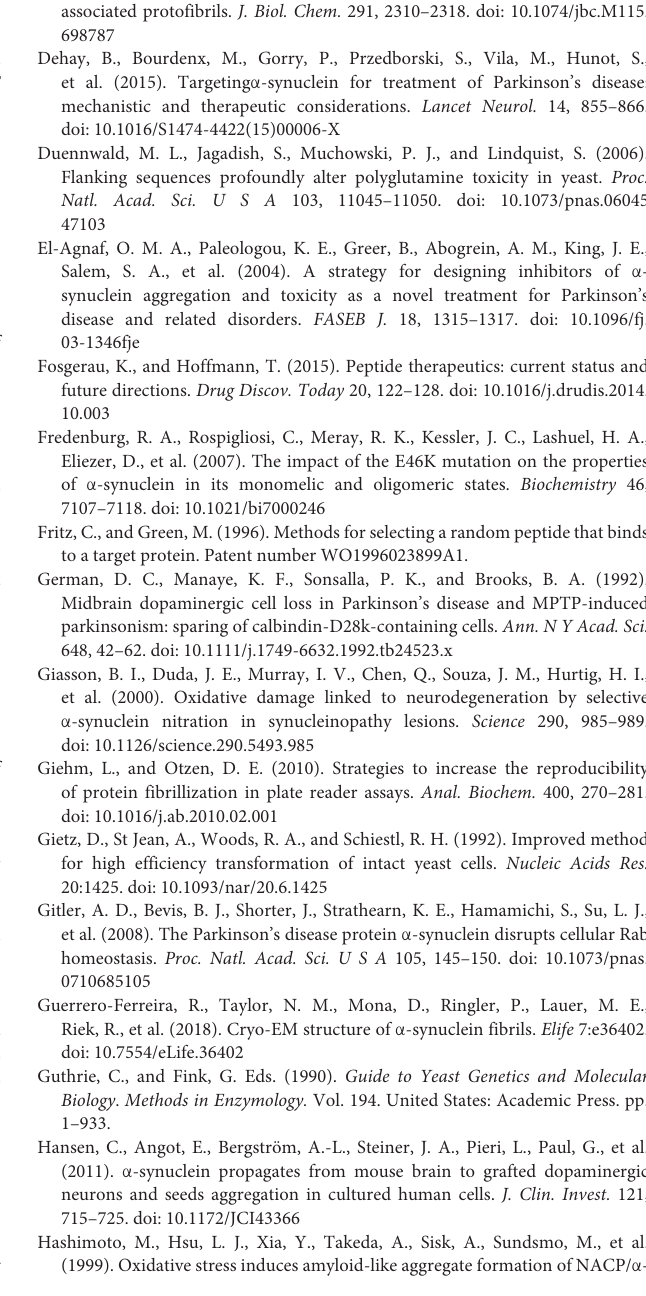
SUPPLEMENTARY FIGURE 7 | Peptide-mediated effect on the amyloidogenic properties of α Syn in vitro . Aggregation kinetics of α Syn in presence or absence of The ThT fluorescence emission was recorded every 15 min for 100 h. Incubation of the peptides alone served as a